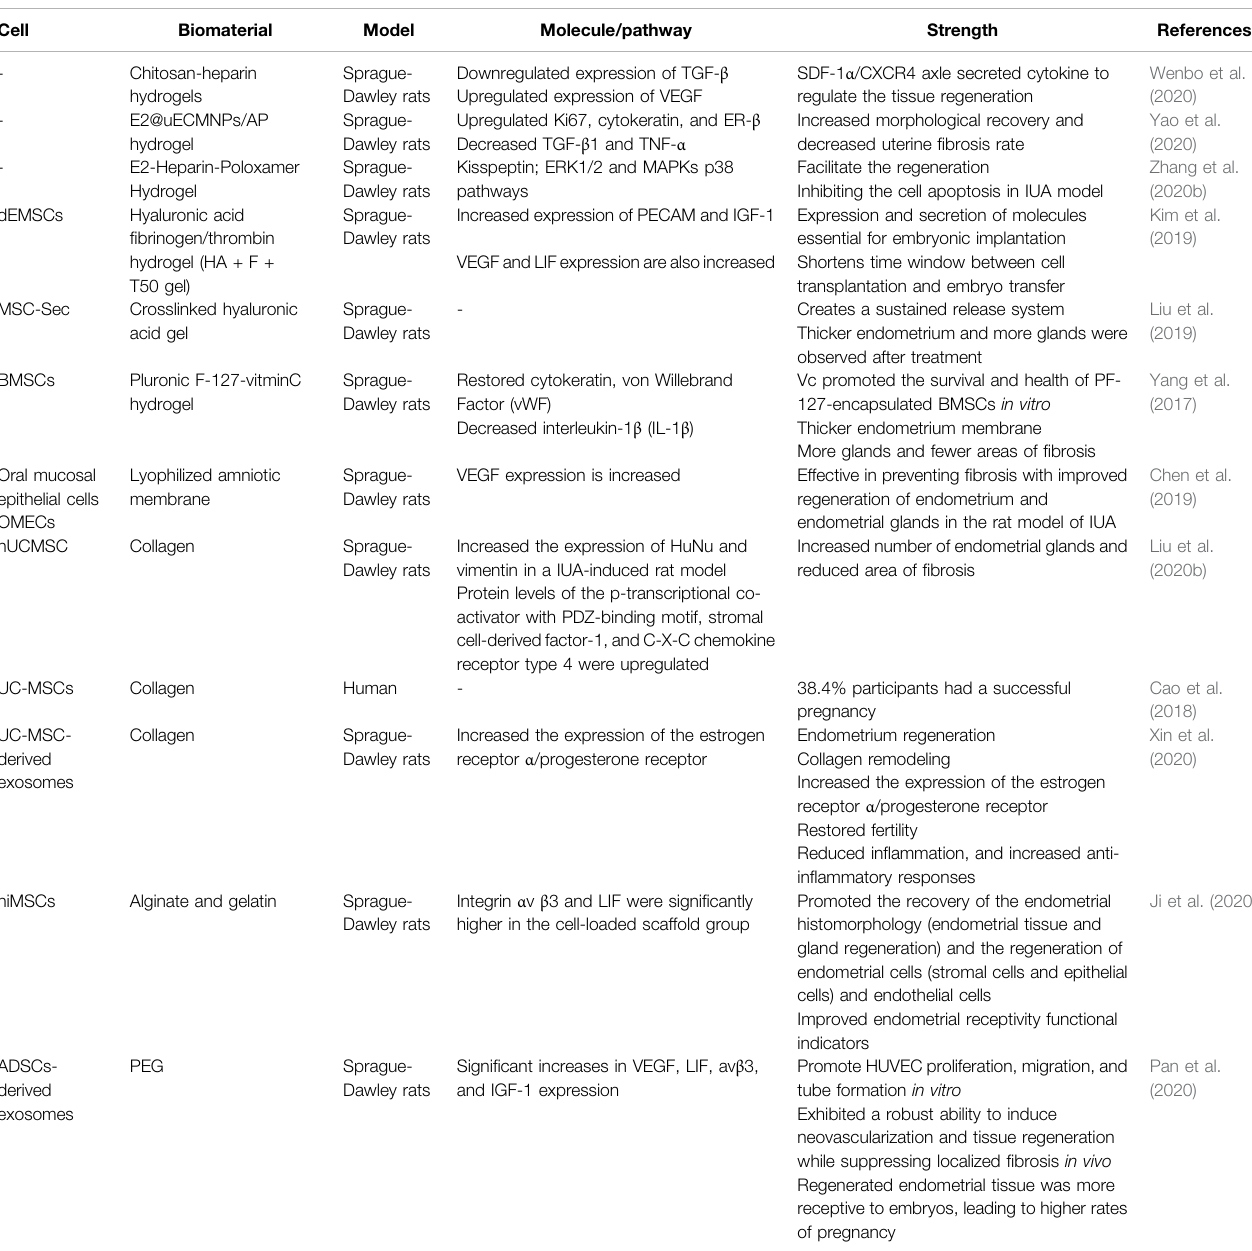
TABLE 2 | Summary of bioactive hydrogels in cell therapy in IUA.